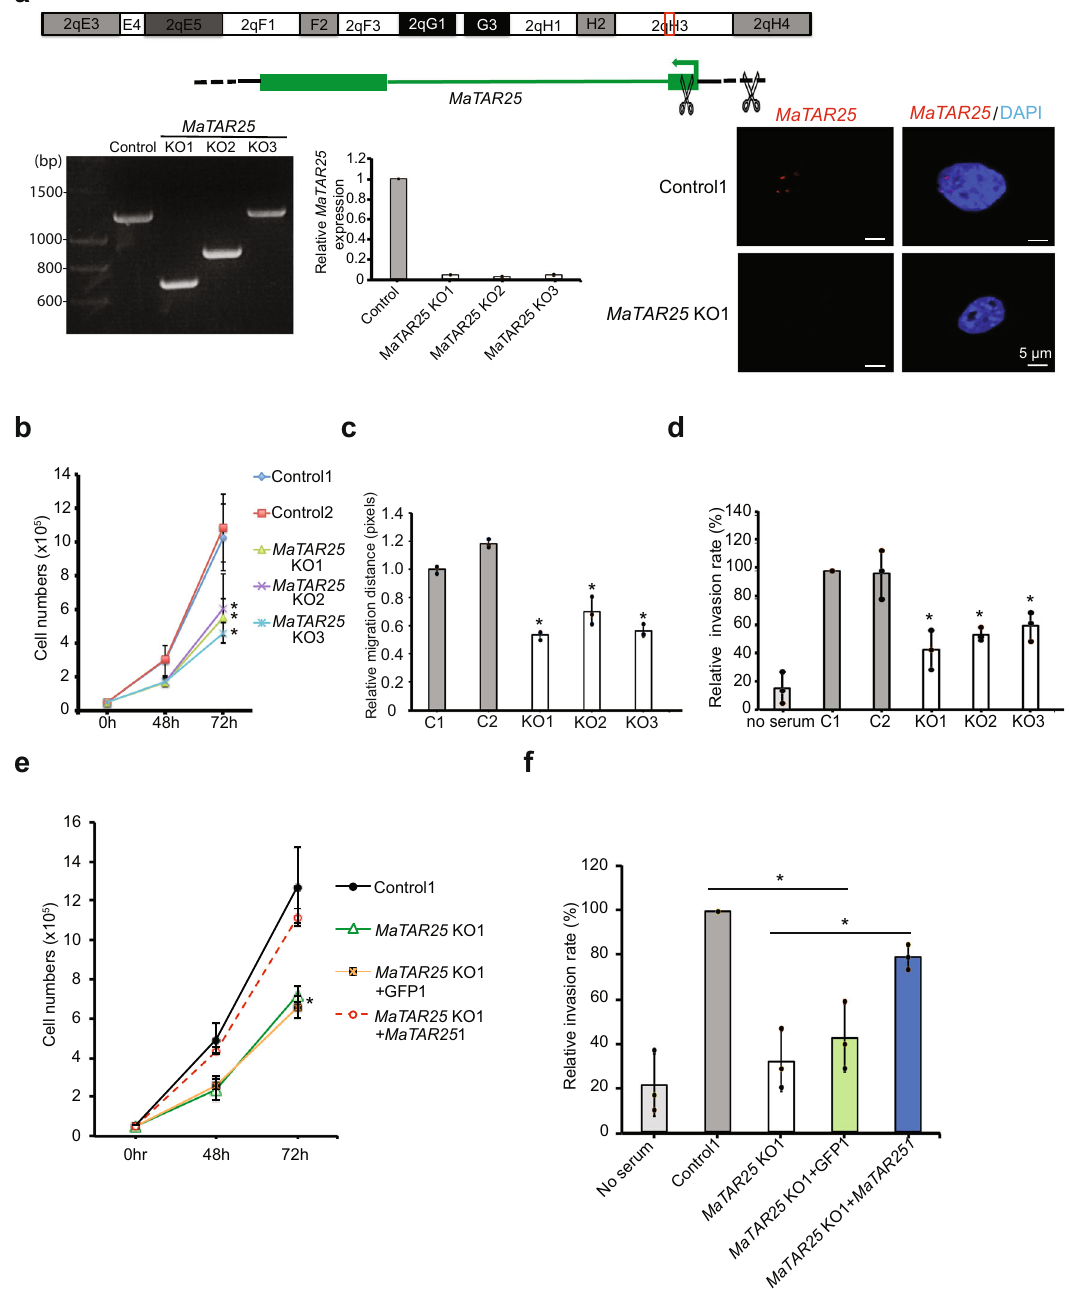
Fig. 2 MaTAR25 knockout affects 4T1 cell viability, migration, and invasion in vitro; all of which can be rescued by ectopic expression of MaTAR25 in knockout cells. a CRISPR/Cas9 was used to generate MaTAR25 KO clones in 4T1 cells. Pairs of sgRNAs were introduced targeting upstream and downstream of the transcription start site of MaTAR25 , resulting in 390 – 620bp genomic deletions over this region, and a Renilla Luciferase sgRNA was used as a negative control. Knockout clones were selected by genomic PCR and Sanger sequencing for homozygous genomic deletion. Control clones were selected by qRT-PCR for expressing similar levels of MaTAR25 as parental 4T1 cells. qRT-PCR ( n = 2), and representative images of single smRNA-FISH (red: MaTAR25 ) are shown to con fi rm MaTAR25 KO. Scale bars are 5 μ m. b 4T1 cells were seeded at the same cell density in 12-well tissue culture plates at day 0, and cell counting was performed at different time points. The mean cell numbers of three independent replicates of 4T1 control groups and MaTAR25 KO groups are shown ± SD ( n = 3). * P <0.05 (paired Student ’ s t test; two-tailed). c Live-cell tracking was performed over time to examine cell migration. Images were collected every 5min for a total of 8h and analyzed by CellTracker image-processing software. The mean relative migration distance ( μ m) of 4T1 control groups and MaTAR25 KO groups is shown ± SD ( n = 3 independent replicates). * P <0.05 (paired Student ’ s t test; two-tailed). d Twenty-four-well Boyden chamber invasion assay (24h). The mean relative cell invasion of three independent replicates of 4T1 control groups and MaTAR25 KO groups is shown ± SD ( n = 3). * P <0.05 (paired Student ’ s t test; two-tailed). e Selected clones with ectopic expression of MaTAR25 or GFP were used as positive and negative controls to assess rescue in a cell viability assay. Data are presented as mean values±SD ( n = 3). * P <0.05 (paired Student ’ s t test; two-tailed). f Cell invasion assay. The mean cell numbers and mean relative cell invasion of three independent replicates of 4T1 control1, MaTAR25 KO1, MaTAR25 KO1 with GFP expression, and MaTAR25 KO1 with MaTAR25 ectopic expression is shown ± SD ( n = 3). * P <0.05 (paired Student ’ s t test;